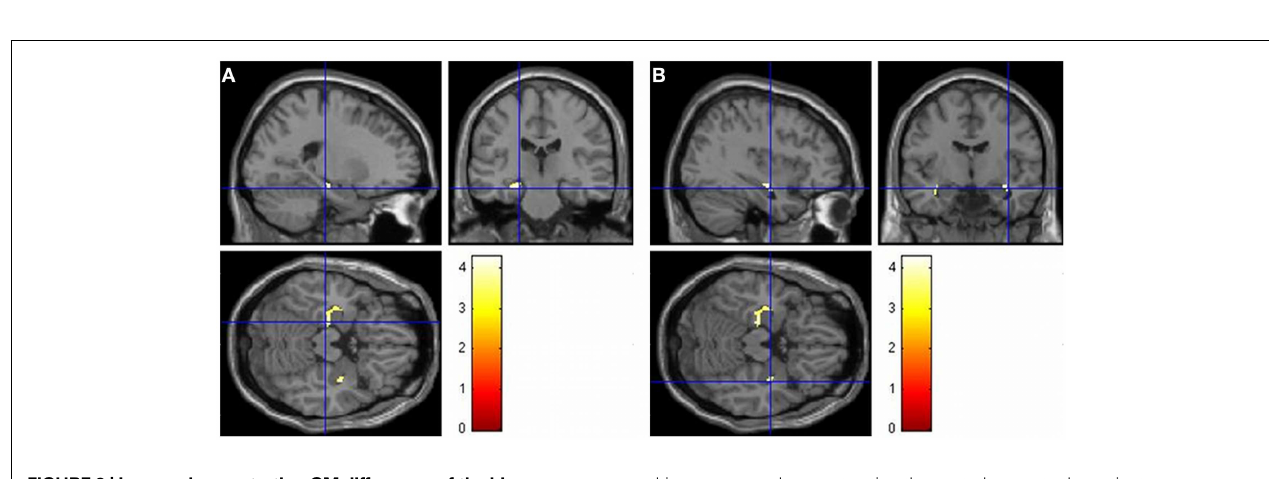
FIGURE 2 | Images demonstrating GM differences of the hippocampus when contrasting controls and patients (controls > patients) .The t maps are superimposed onto an anatomical brain and displayed in the sagittal, coronal, and horizontal planes. (A) GM differences in the left